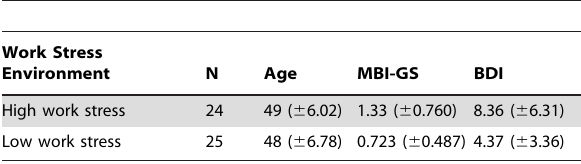
Table 1. Demographic data of the nurse groups by work